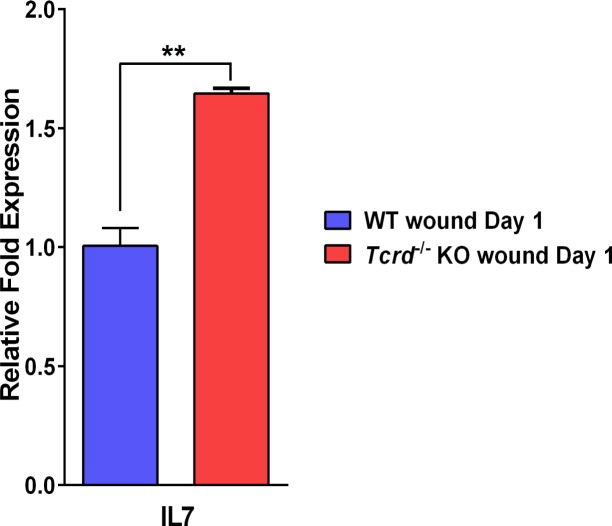
IL-7 expression in excisional wounds.qPCR measurements of levels of IL-7 expression by keratinocytes. Data are the fold difference ± SEM of three samples per genotype analyzed in triplicate. The levels of IL-7 in the γδT-cell KO wounded skin are higher than those in the wounded wild-type skin. **p<0.001.